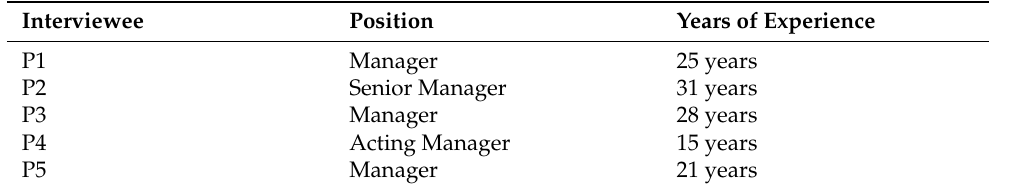
Table 2. Profile of Interviewees.